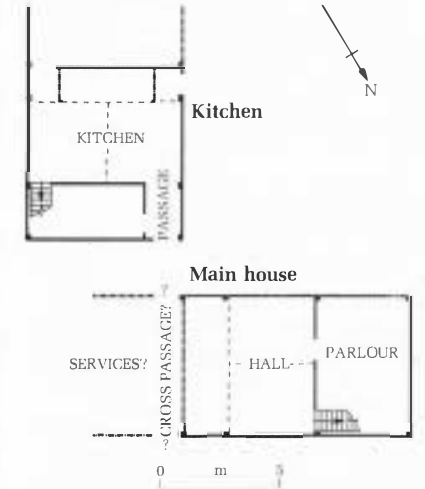
Figure 5 Plan of the early to mid-six­ teenth centwy house and kitchen at Dar­ well Beech (Mountfield, Sussex). Note the passage that, as at Comphurst (Fig. 3}, leads towards the house.